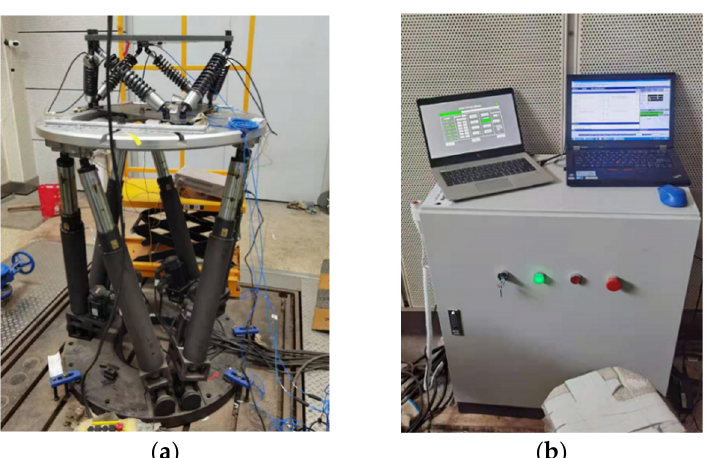
Figure 17. Vibration test system of the multi-dimensional damping seat test platform. ( a ) 6-DOF vibration test bench; ( b ) vibration test bench control system.